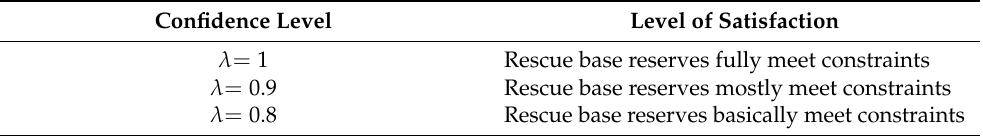
Table 1. Confidence level and its signification. Confidence Level Level of Satisfaction λ = 1 Rescue base reserves fully meet constraints λ = 0.9 Rescue base reserves mostly meet constraints λ =